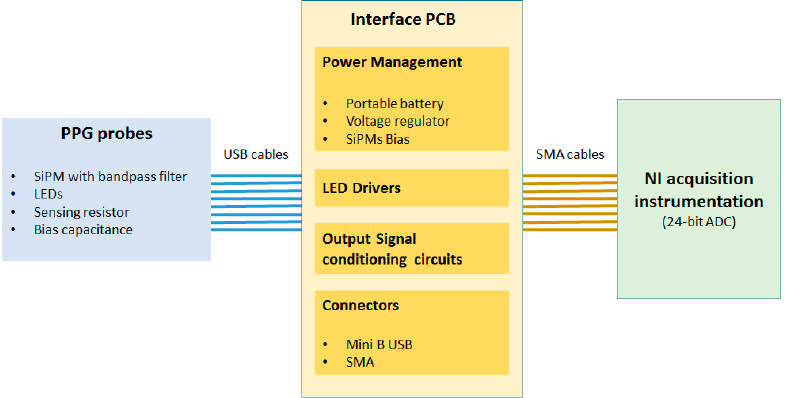
Figure 3. PPG Signal Sampling pipeline: System Architecture.